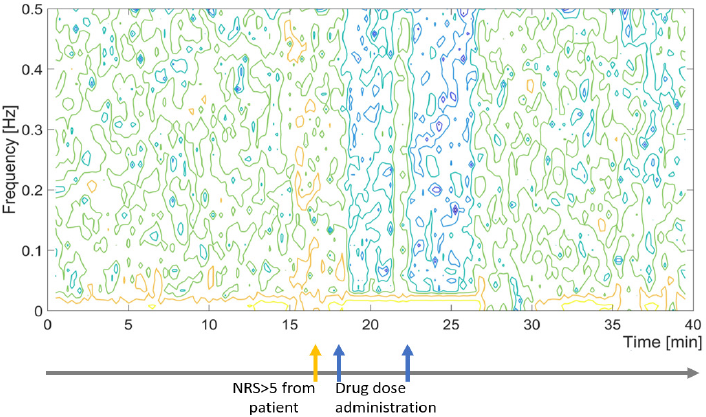
Figure 6. Sample spectrogram and log events for measured impedance values with ANSPEC-PRO for one patient during first 40 minutes in PACU.